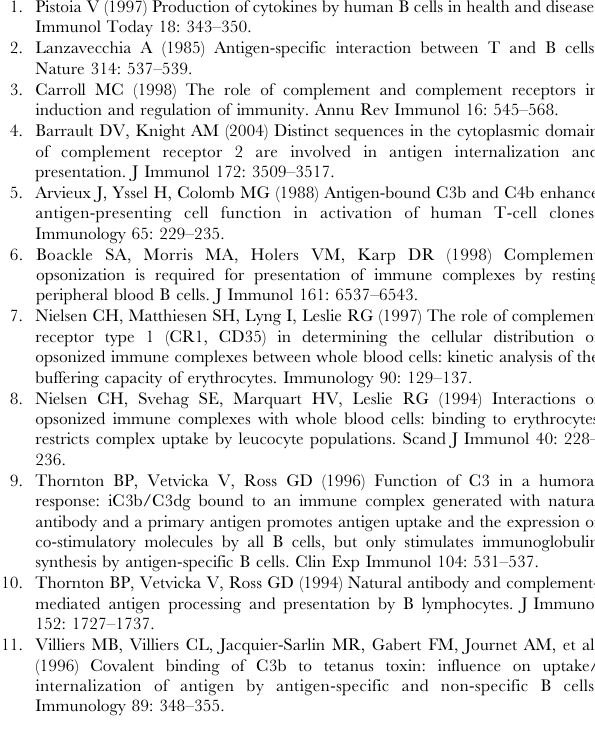
Shown is the percentage of MK16- and MK16 + B cells expressing CD5 (A), CD24 (B), CD1d (C), or IgM (D) among B cells. MFI values are shown as mean 6 SEM. (TIF) Figure S3 Cytokine secretion by MBP85-99 presenting B cells. PBMCs from four healthy HLA-DR15 + donors were incubated for 18 hours with or without MBP (30 m g/ml) in RPMI medium containing 30% (v/v) normal serum. Cells were stained with PerCP anti-human CD19, biotinylated MK16 + PE-streptavi- din, APC-anti-human IL-10, FITC anti-human IL-6 and life/ dead cell discriminator LIVE/DEAD Fixable Near-IR. A) Representative dot plot showing IL-10 and IL-6 secretion by MBP85-99 presenting, live B cells. B) The percentages of IL-10 producing or C) IL-6 producing, live B cells are shown as means and SEM. As positive control, a combination of MBP, phorbol myristate acetate and ionomycin (PMAiono) was used as stimulating agent.